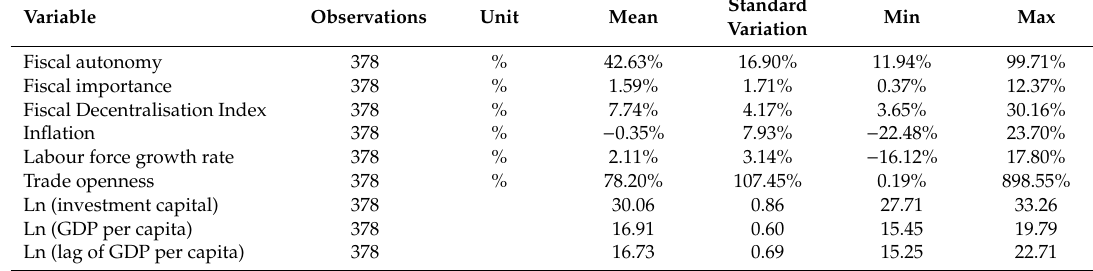
Table 2. Descriptive statistics of variables in the model.